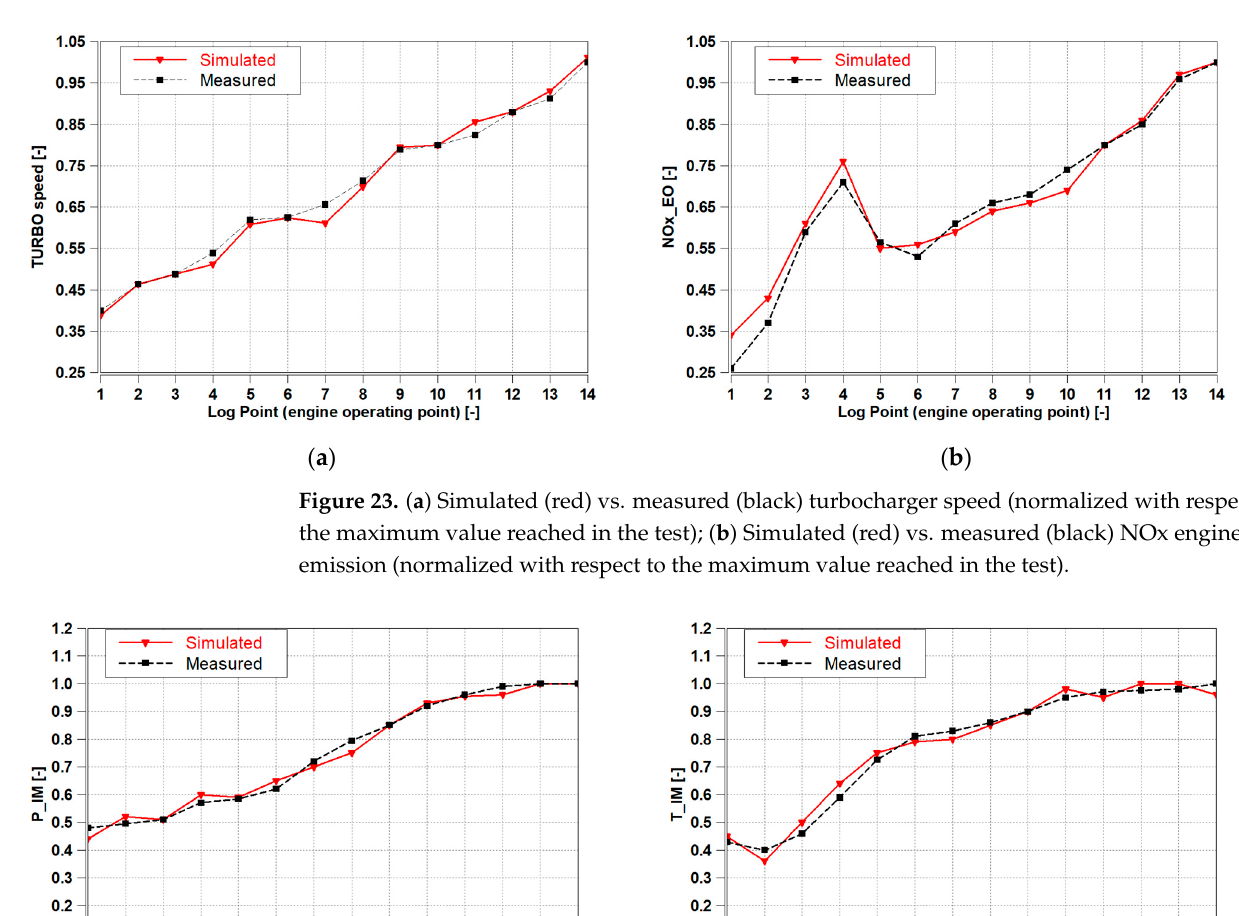
Figure 23. ( a ) Simulated (red) vs. measured (black) turbocharger speed (normalized with respect to the maximum value reached in the test); ( b ) Simulated (red) vs. measured (black) NOx engine out emission (normalized with respect to the maximum value reached in the test).